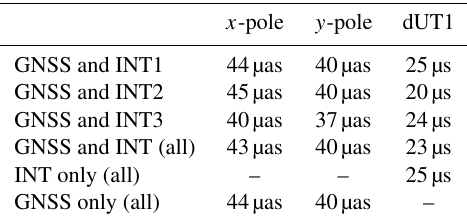
Figure 5. Difference of the combined ERP results w.r.t. IERS 14 C04 Table 5. Comparison of the GNSS/VLBI combination results with the IERS 14 C04 time series: WRMS deviation of